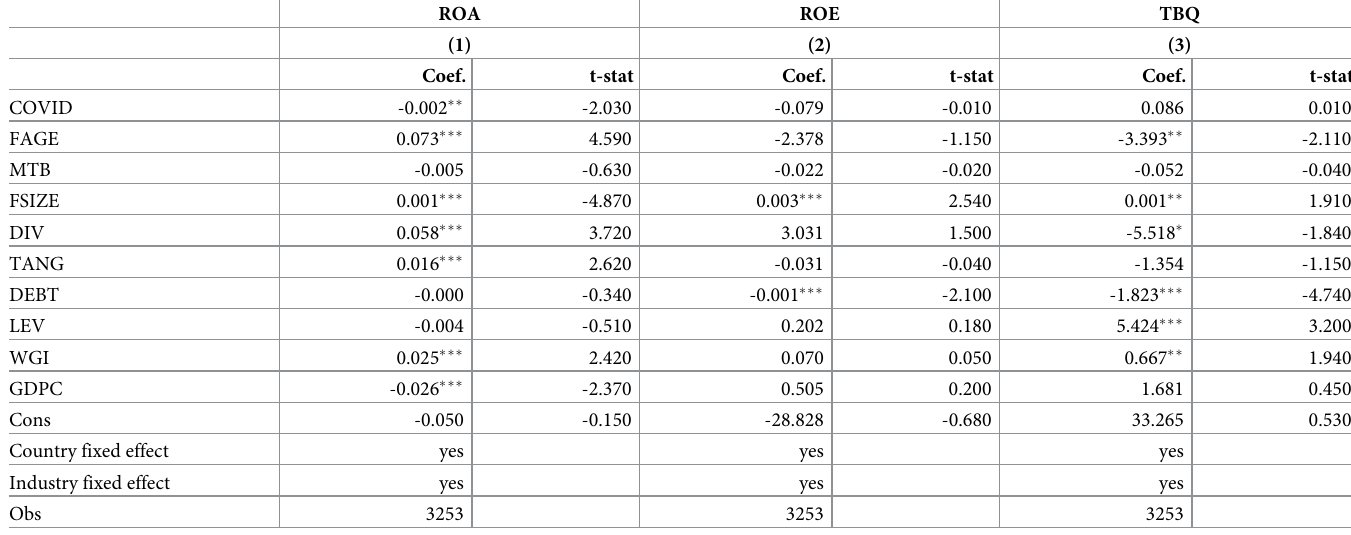
Table 4. COVID-19 and firm performance results.